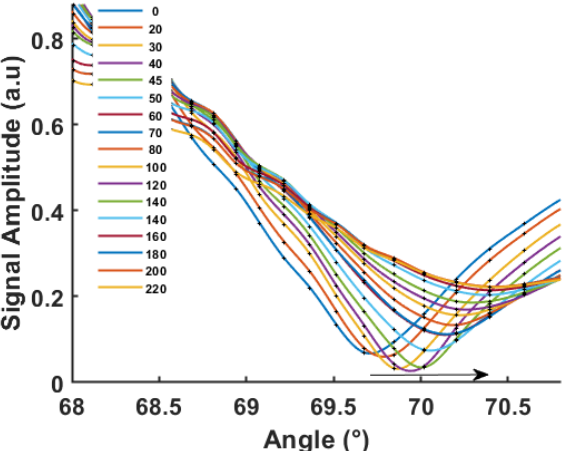
Figure 5. SPR curves in PBS solution for the Al 2 O 3 protected copper for different time variations for the position of the minimum angle versus time for Cu thin films deposited on glass (46 nm) covered by 2 to 3 nm of Al 2 O 3 being in contact with a PBS buffer electrolyte. The time is given in minutes in the legend.